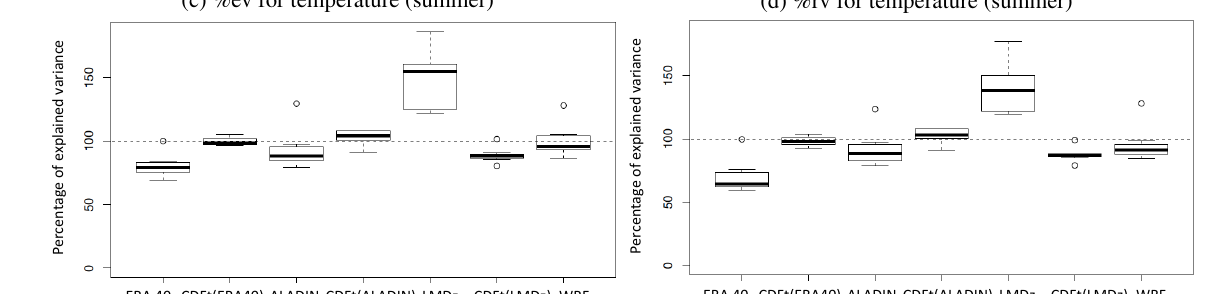
Fig. 4: Same as Fig. 3 but for summer.